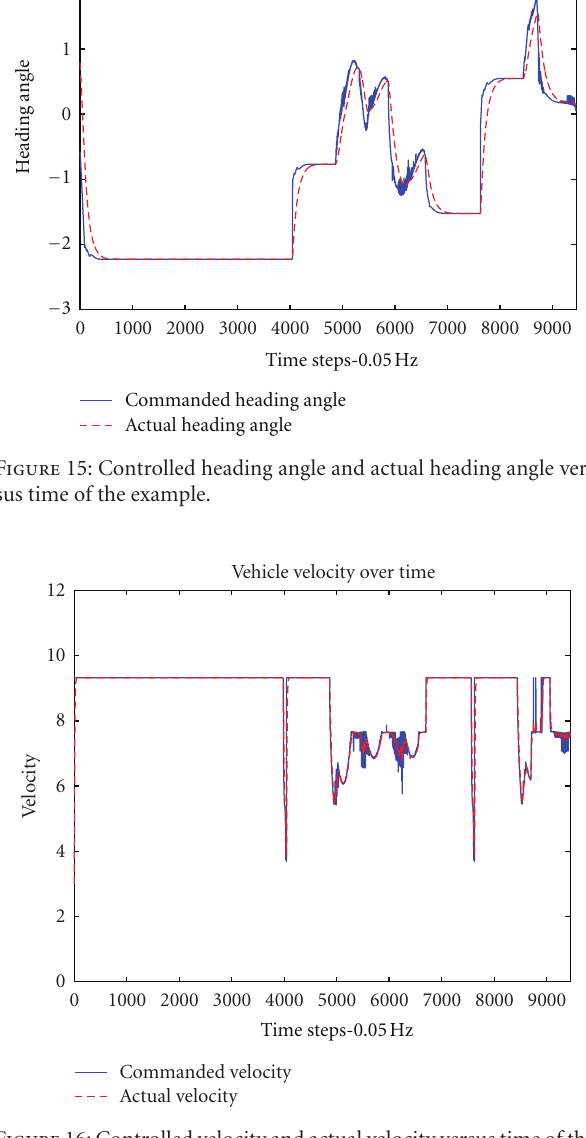
Figure 16: Controlled velocity and actual velocity versus time of the example.